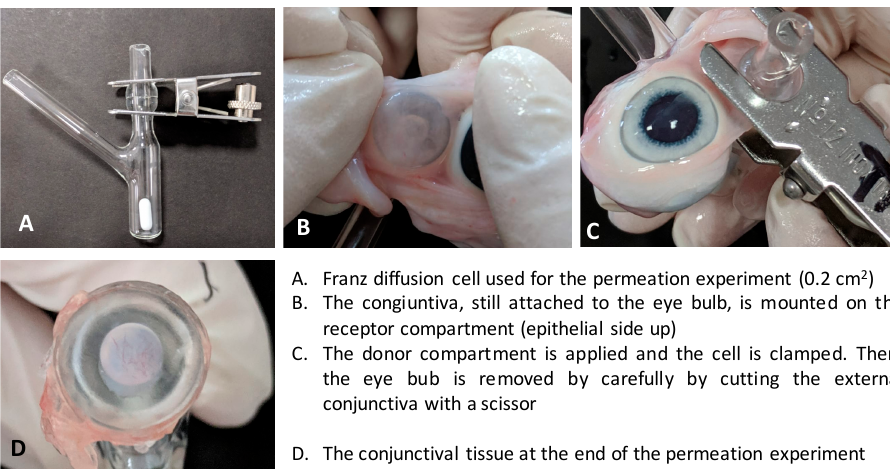
formulation P at 25 °C. Figure S1. SAXS spectra of mixed TP micelles (50:50 mole ratio) prepared with different protocols.